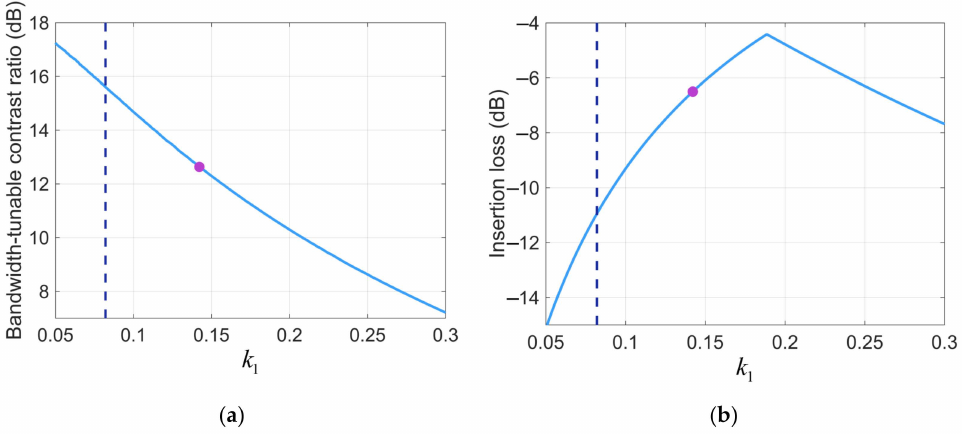
Figure 7. System performance under different initial coupling states. ( a , b ) The evolution of the bandwidth- tunable contrast ratio and insertion loss of the system with the coupling coefficient k 1 ,